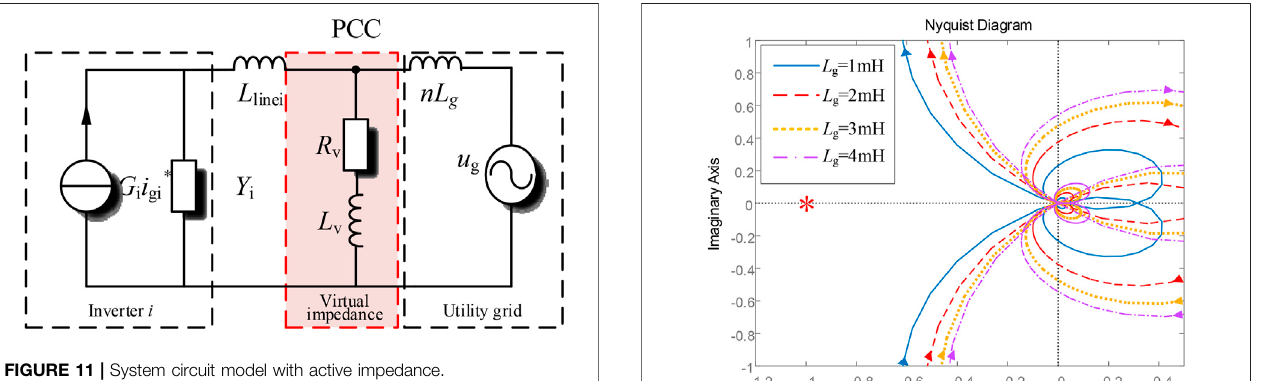
FIGURE 11 | System circuit model with active impedance.